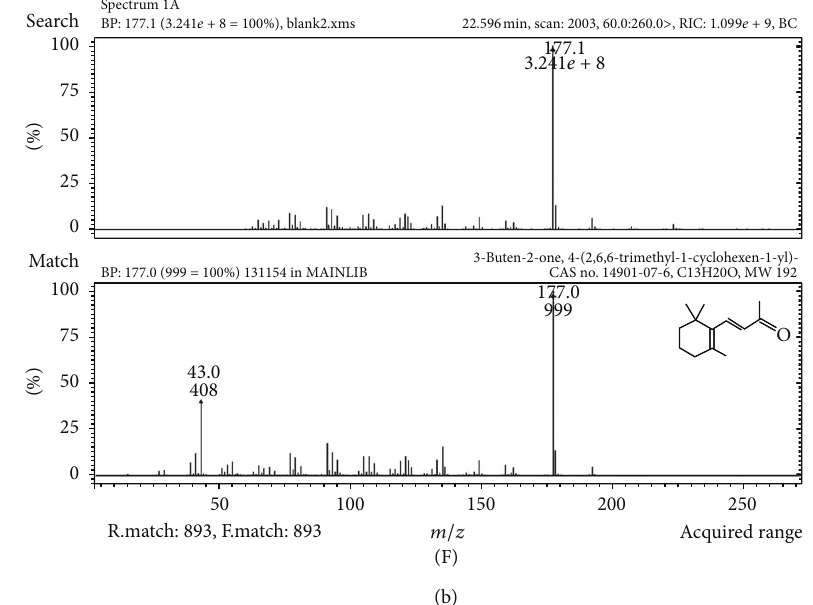
Figure 3: (a) MS-chromatogram of water sample (total ion current of the MS in the select ion mode) and (b) mass spectra of the six target compounds. Shown are (A) DMTS , (B) IBMP , (C) 2-MIB , (D) 𝛽 -cyclocitral, (E) GSM , and (F) 𝛽 -ionone for both (a) and (b). Table 4: The concentration of the five odors detected in waterworks from Wuxi city (all samples were test two times).